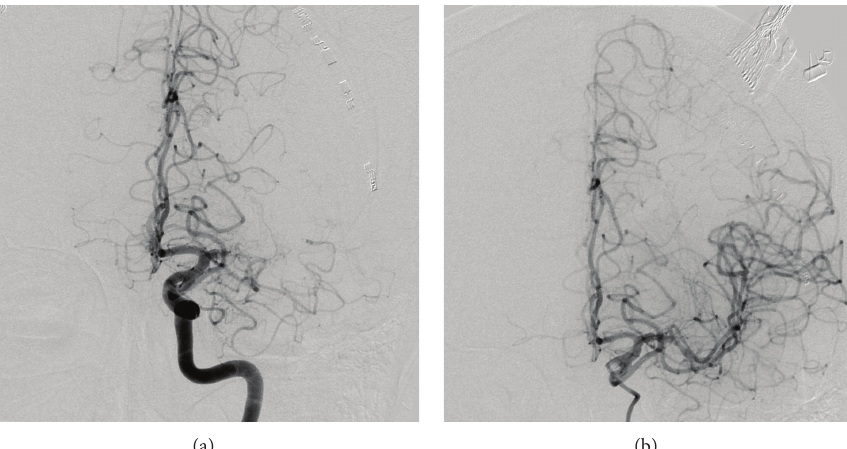
Figure 1: Findings before (a) and after (b) the first thrombectomy with 5 thrombectomy maneuvers of the left medial cerebral artery in the M1